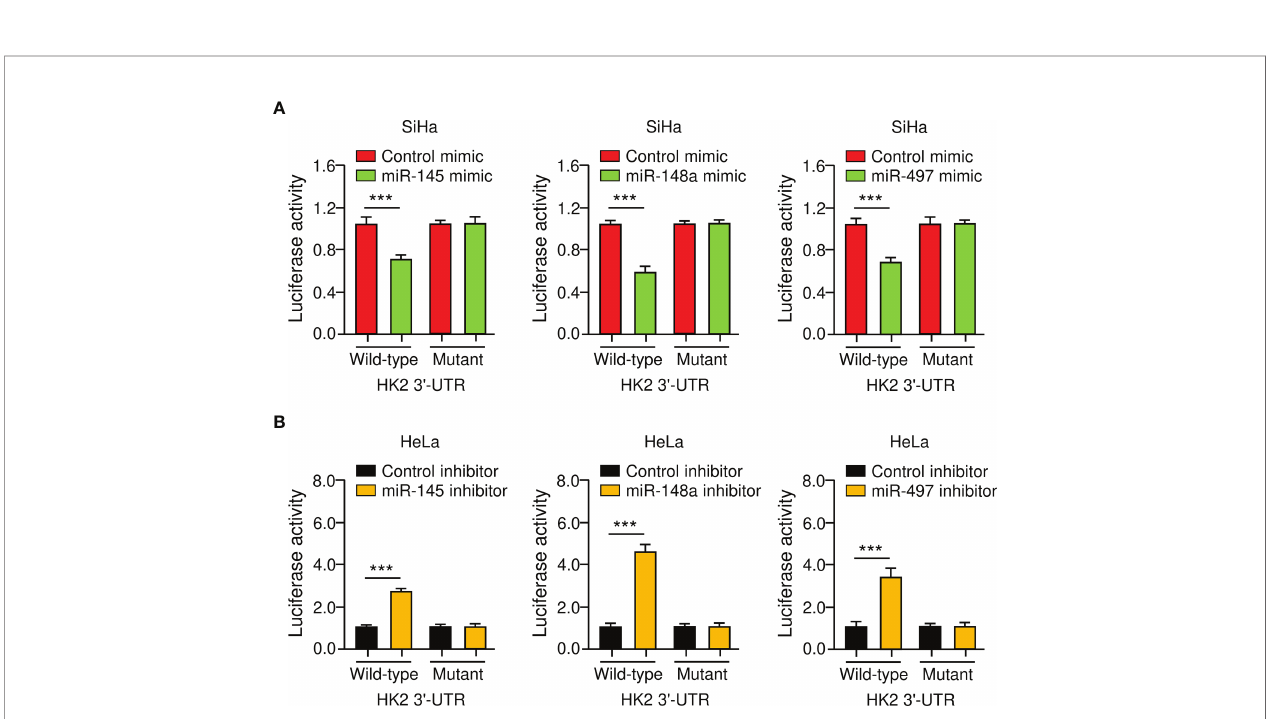
FIGURE 4 | HK2 is a Direct Target Gene of MiR-145/148a/497 in CC Cells. (A, B) Luciferase reporter assays of CC cells that were co-transfected with indicated miRNA mimics (A) or miRNA inhibitors (B) and luciferase vector containing the wild-type or mutated HK2 3 ′ -UTR. *** P < 0.001.